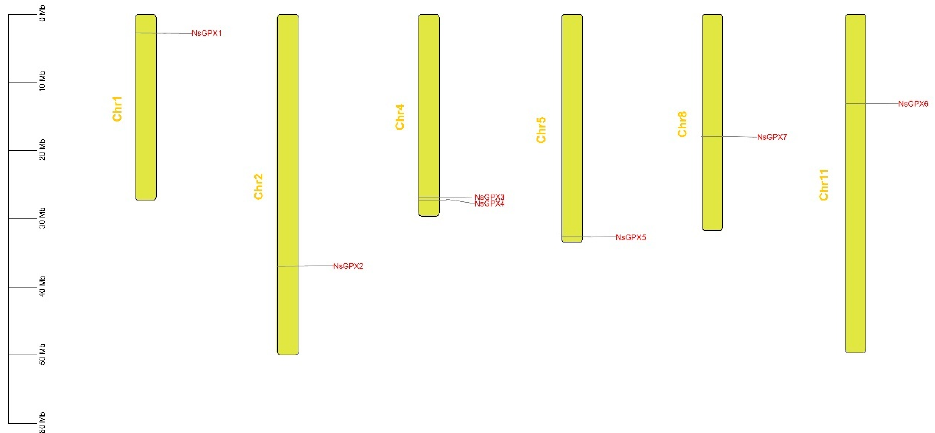
Figure 2. Chromosome location of NsGPX genes. Each chromosome gene names of each GPX genes on the right side coincide to their approximate locations.